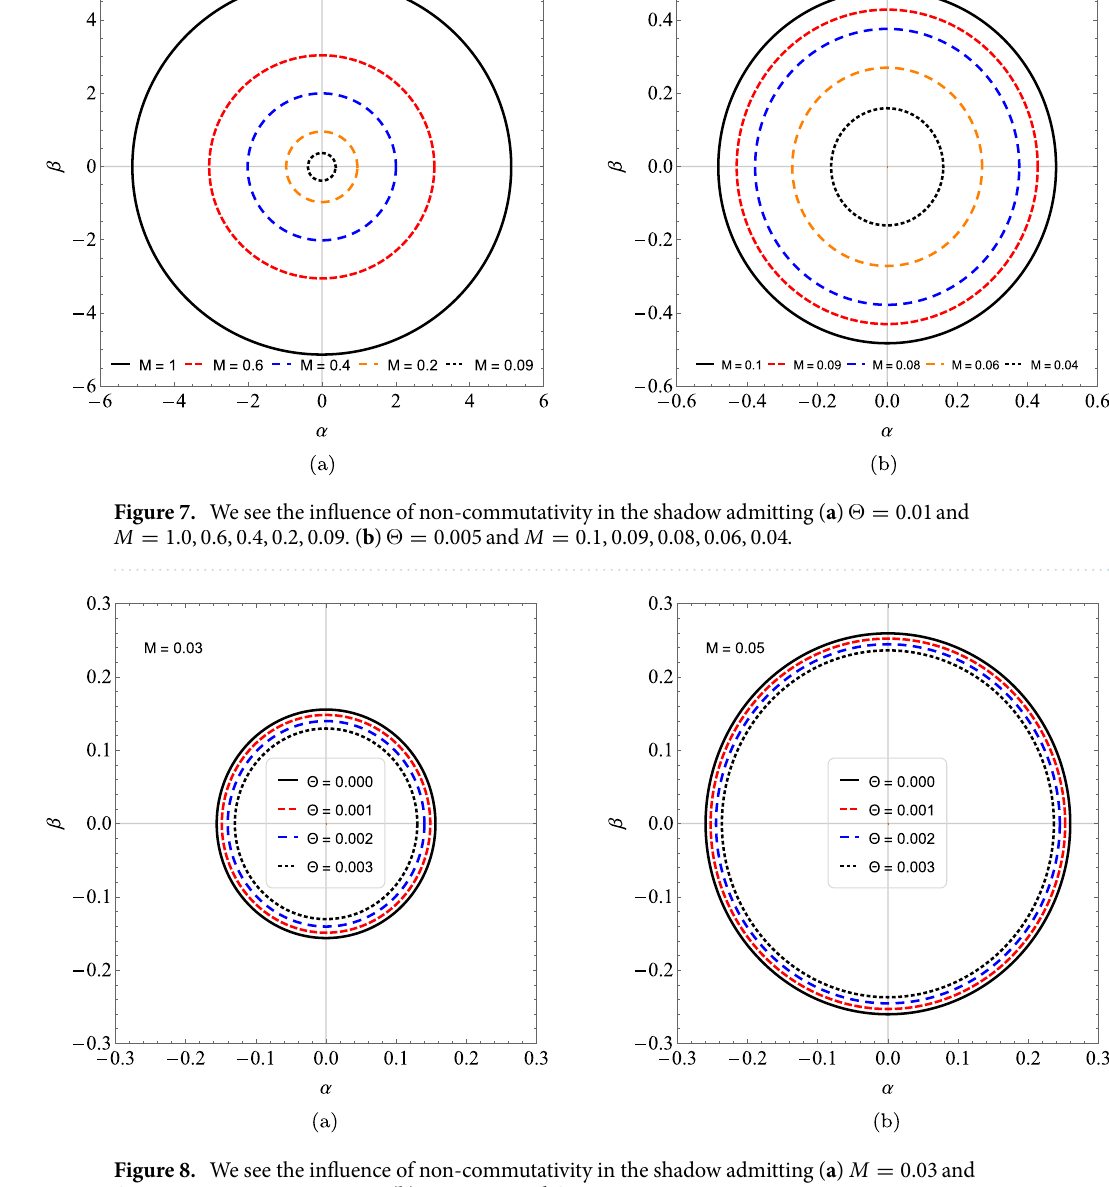
Figure 8. We see the influence of non-commutativity in the shadow admitting ( a ) M = 0.03 and (cid:31) = 0.000, 0.001, 0.002, 0.003 . ( b ) M = 0.05 and (cid:31) = 0.000, 0.001, 0.002, 0.003